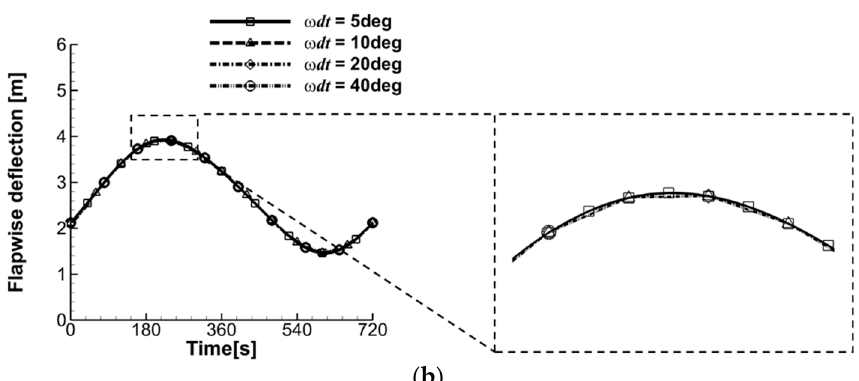
Figure 8. Effect of time step size on the rotor power coefficient and blade tip deformation for one period of platform surge motion. ( a ) Rotor power coefficient. ( b ) Flapwise tip deformation.